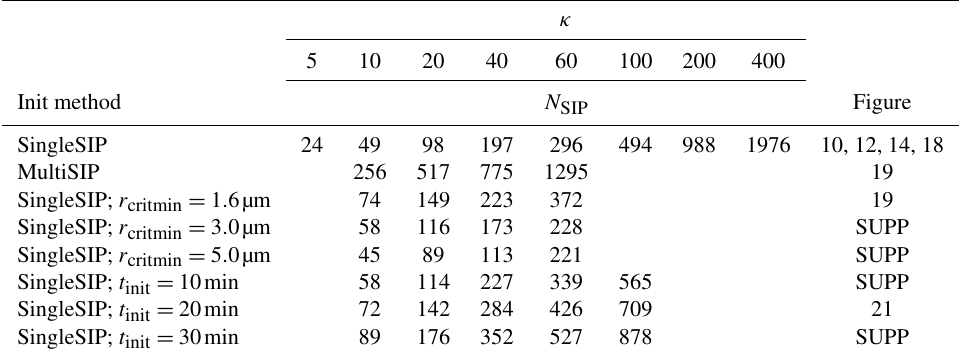
Table 3. Number of SIPs for the probabilistic singleSIP-init method (and variants like the multiSIP-init) as a function of κ . The given values are averages over 50 realisations and rounded to the nearest integer. The right-most column lists the figures in which simulation results with this specific init method are depicted. SUPP refers to the Supplement of this